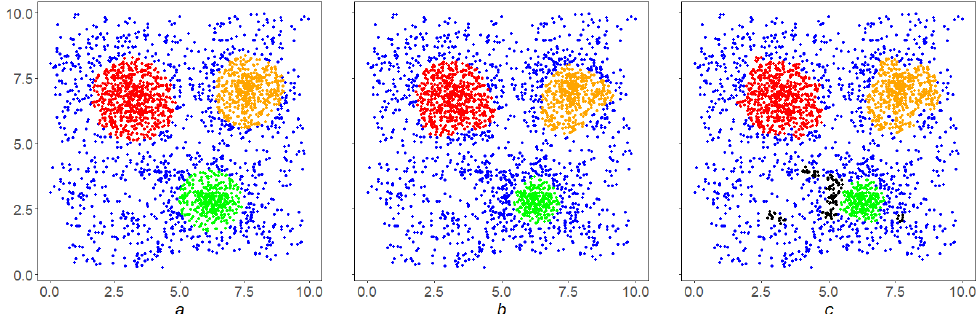
Figure 7. Dependence of the result of the SDPS algorithm on the parameter q : ( a ) the result of the SDPS algorithm at q = − 2; ( b ) the result of work at q = − 2.8; and ( c ) the result of work for q = − 3.5 (in all cases β = − 0.2, p = 0).